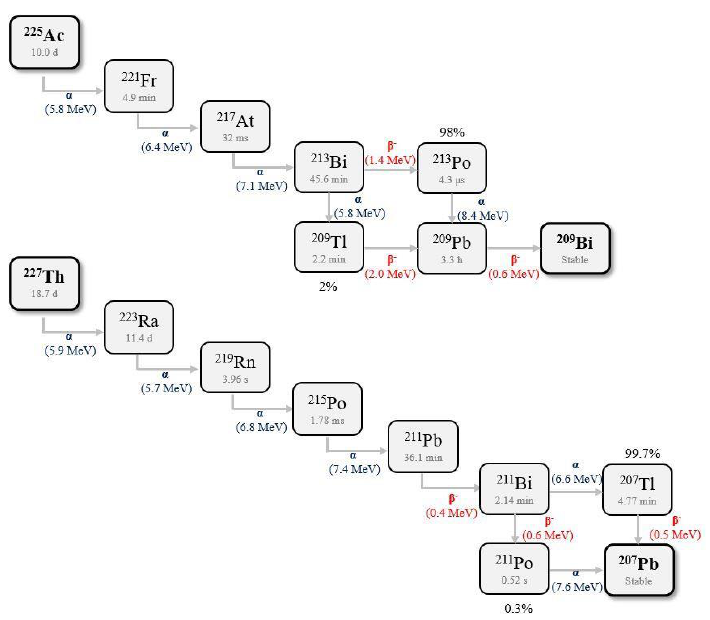
Figure 1. Decay chains of 225 Ac and 227 Th- 223 Ra radionuclides.